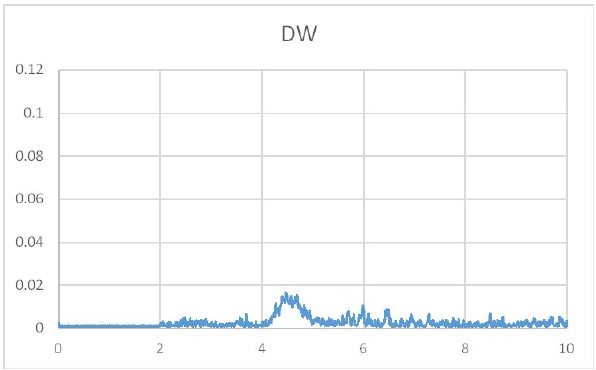
Figure 10. Delays on the path 2–11: DA method.